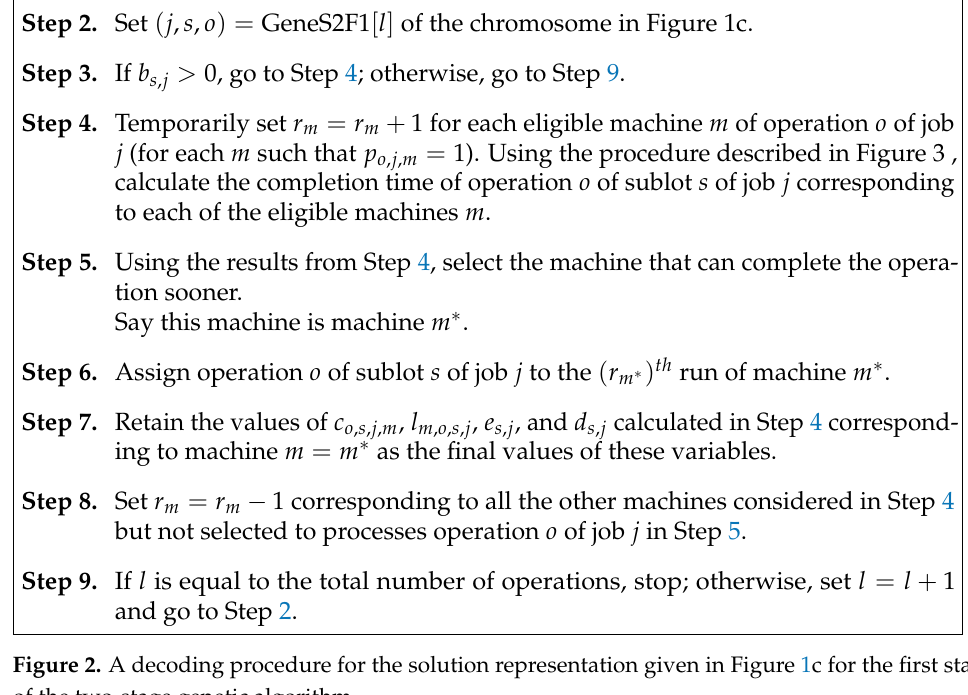
Figure 2. A decoding procedure for the solution representation given in Figure 1c for the first stage of the two-stage genetic